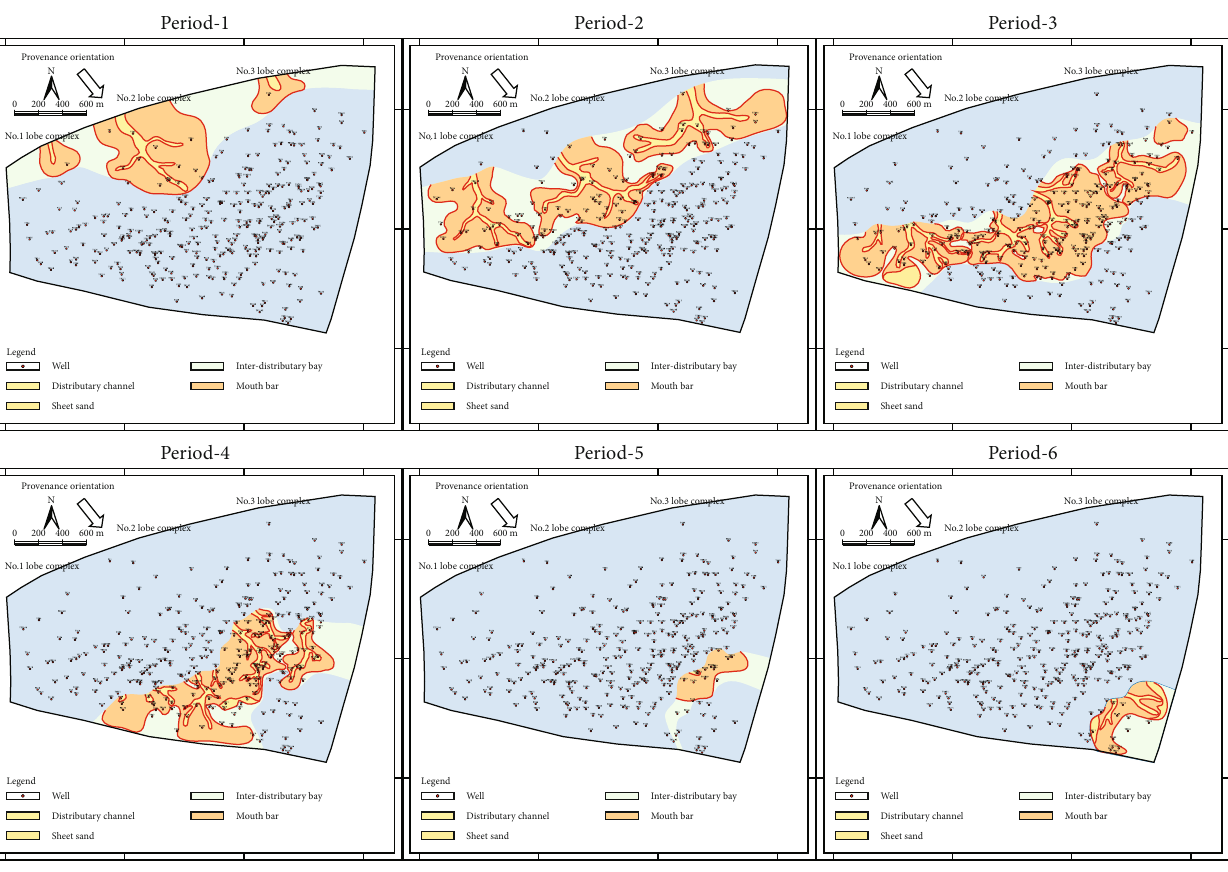
Figure 13: Plane view of division of sedimentary microfacies period in VII-15